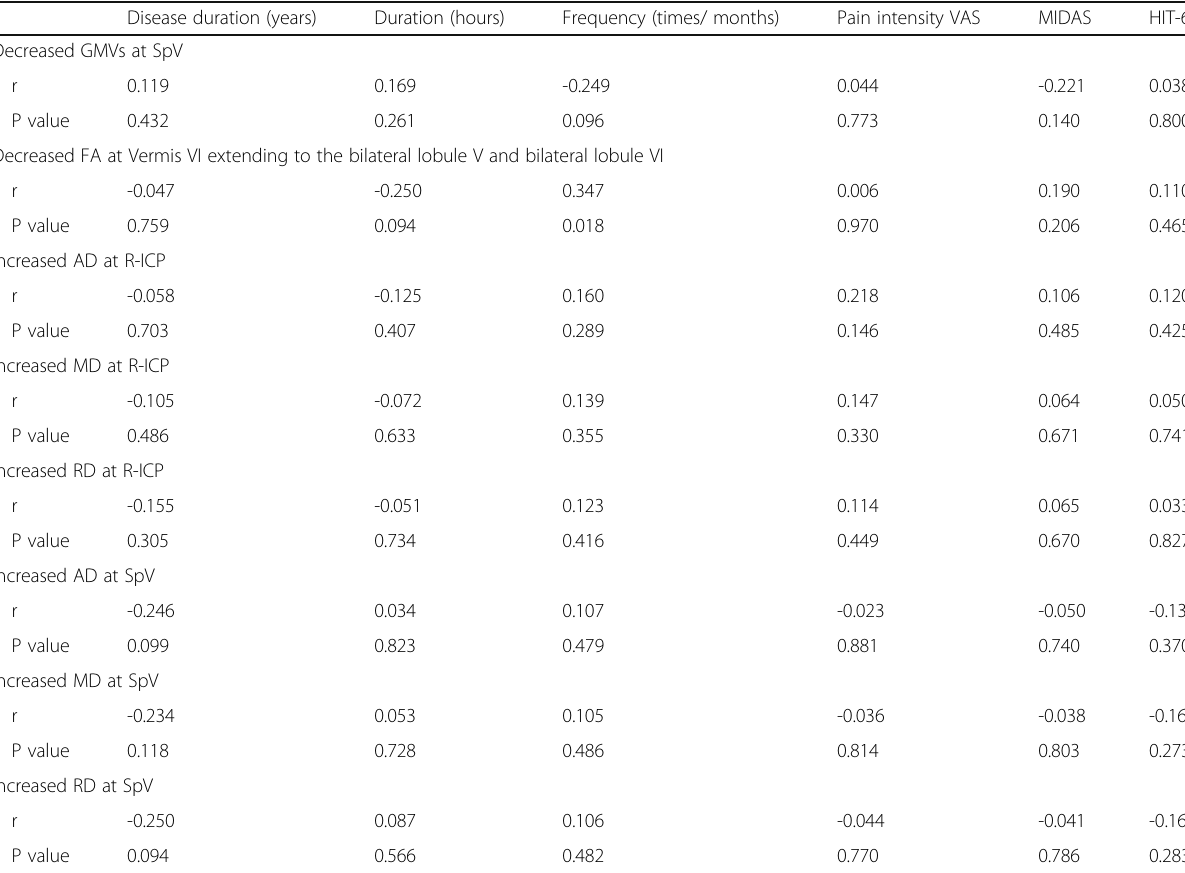
Table 4 Clinical correlations with altered GMVs and diffusion characteristics of patients with MWoA. Disease duration